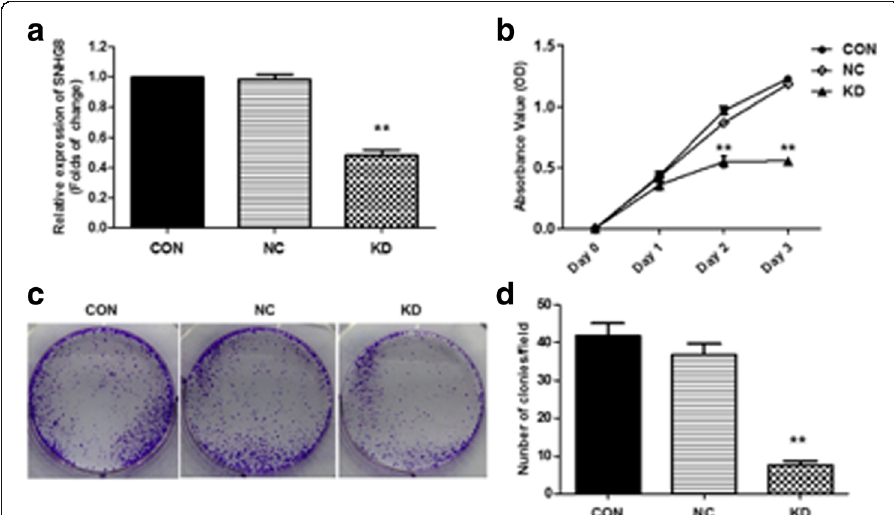
Fig. 2 Knockdown of SNHG8 inhibits cell proliferation and clonogenic potential in GT38 cells. a The specific shRNA sh-SNHG8 decreased the SNHG8 level by up to 57% in GT38 cells. ** p < 0.01. b The results of 3 consecutive days of cell viability assessments for GT38 cells with (KD group) or without (NC group) specific shRNA transfections and blank control cells (CON group). c GT38 cells with (KD group) or without (NC group) specific shRNA transfections and blank control cells (CON group) were subjected to colony formation assays. After crystal violet staining, colonies were visually observed. d Counting of colonies showed that colony numbers had significantly decreased in the KD group. ** p <0.01 compared with NC group. CON, blank control cells without transfection; NC, negative control; KD, SNHG8 knockdown